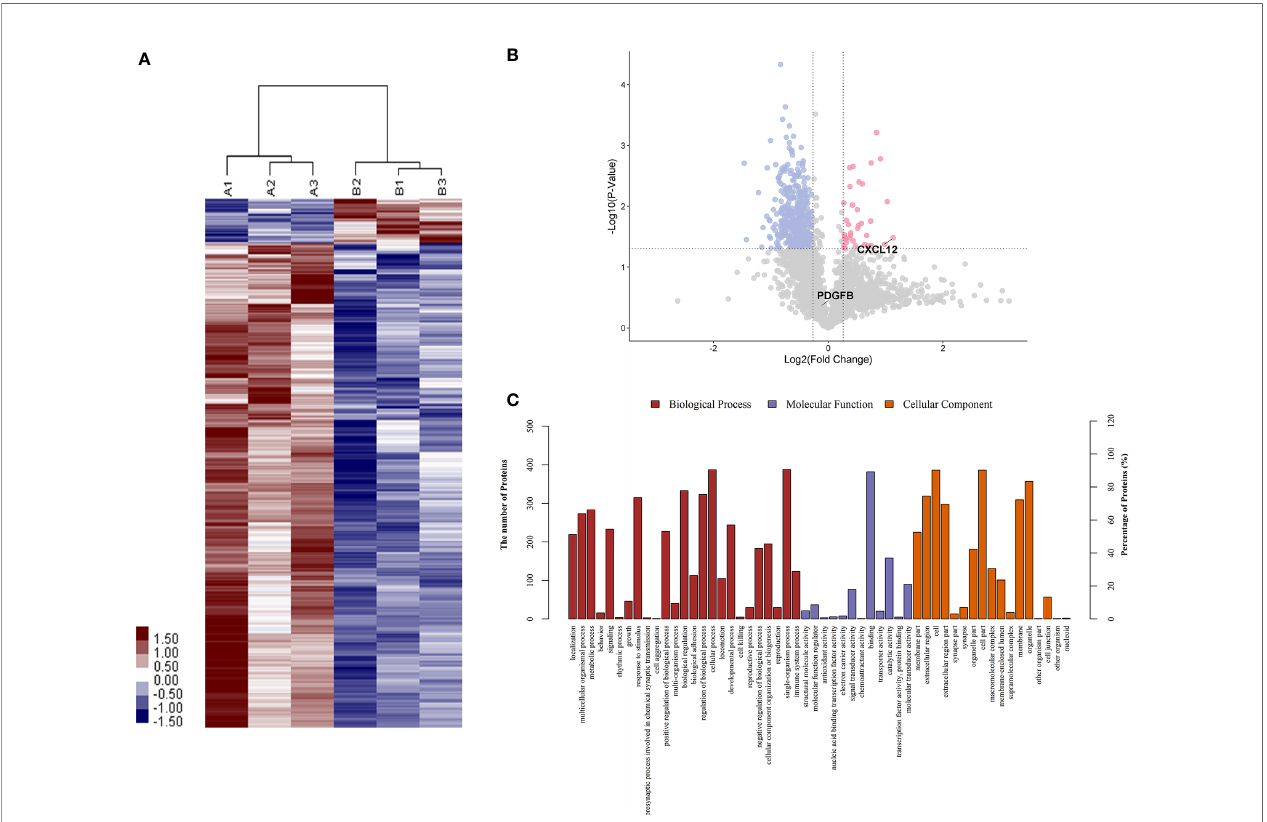
FIGURE 1 | The differentiated urine proteins between patients with TAPS and HCs analyzed by iTRAQ study. (A) Cluster analysis of patients with TAPS with HCs (A represented HCs; B represented TAPS). (B) Volcano plot showed that CXCL12 was in the upper right quadrant, which was in pink color area. (C) Gene ontology (GO) analysis of TAPS vs HCs. iTRAQ, isobaric tags for relative and absolute quanti fi cation; TAPS, thrombotic antiphospholipid syndrome; HCs, healthy